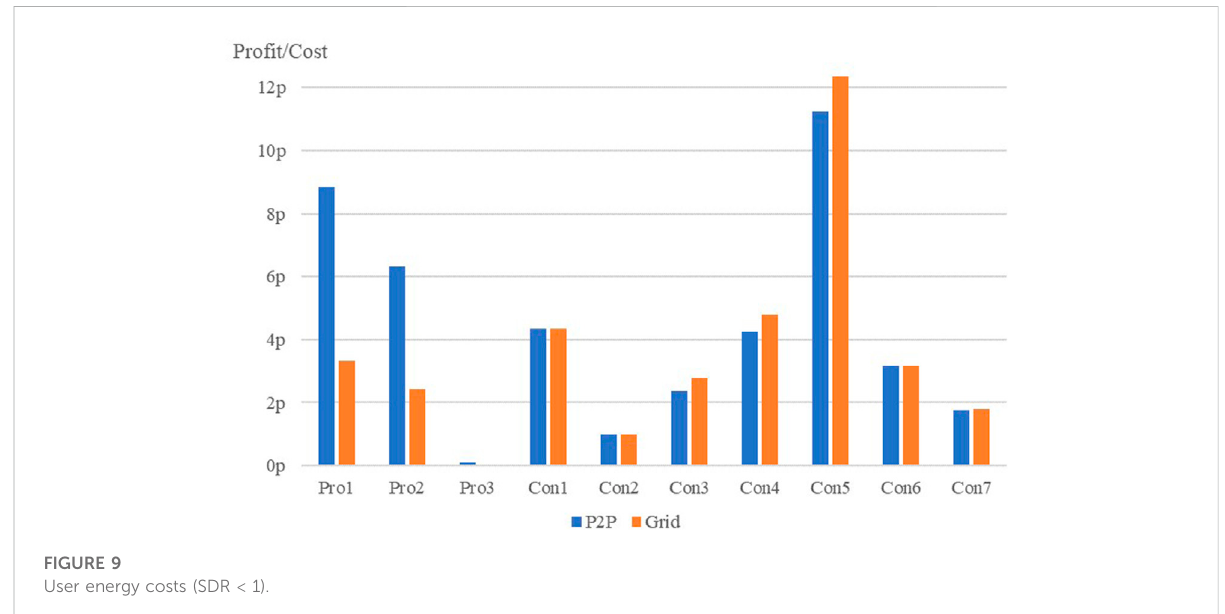
FIGURE 9 User energy costs (SDR < 1).